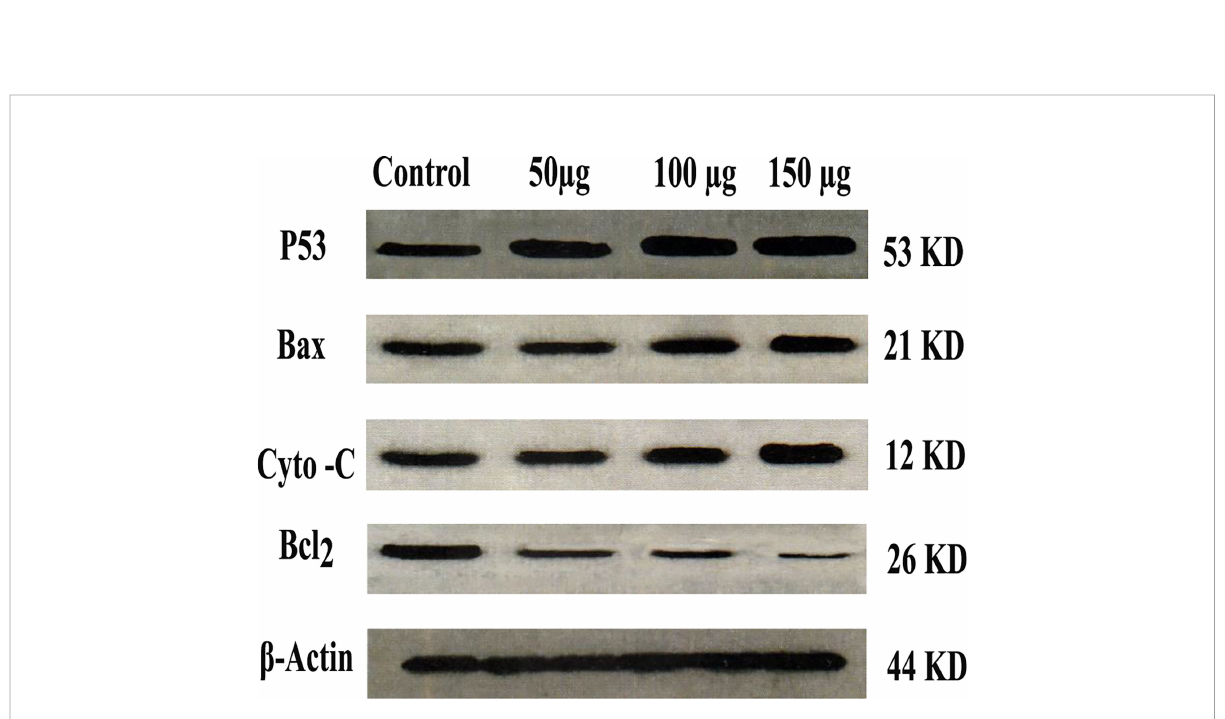
FIGURE 9 Western blot of P53, Bax, Cytochrome C and BcL 2